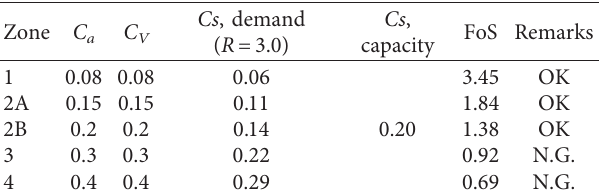
Figure 20: Calculation of R factor based on the IDA analysis, R � R (a) IDA-based capacity curve. (b) IDA-based response curve. Table 2: Seismic performance of as-built RC frame in various seismic zones.